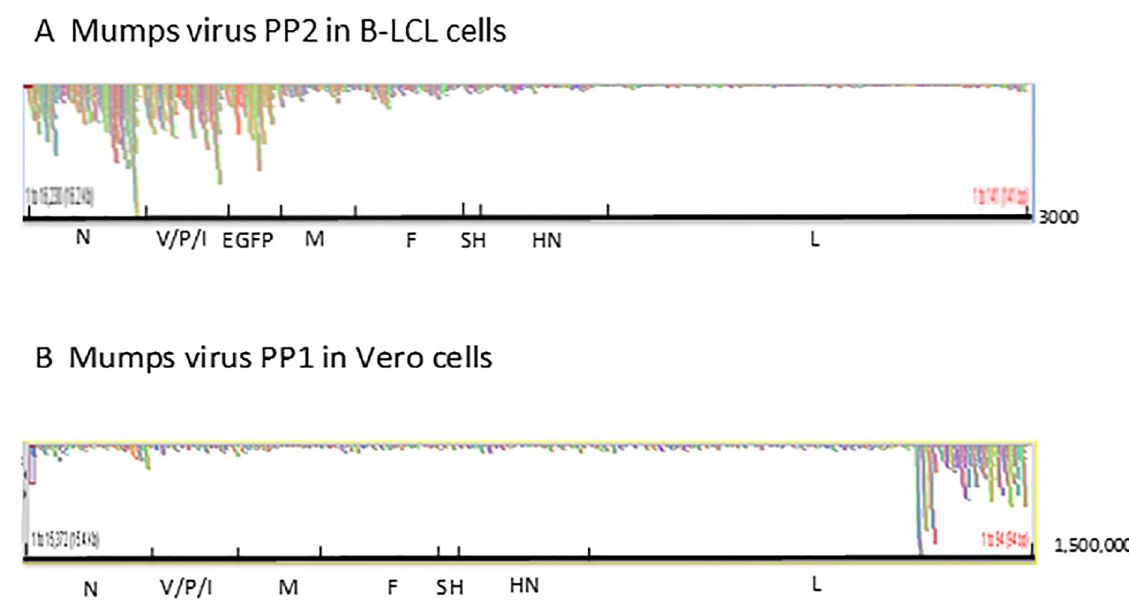
Fig 1. Coverage of reads and preponderance of defective interfering RNAs in passages of viruses on Vero and B-LCL cells. Coverage of reads and preponderance of Defective Interfering RNAs after 6 passages of viruses on Vero and B-LCL cells.